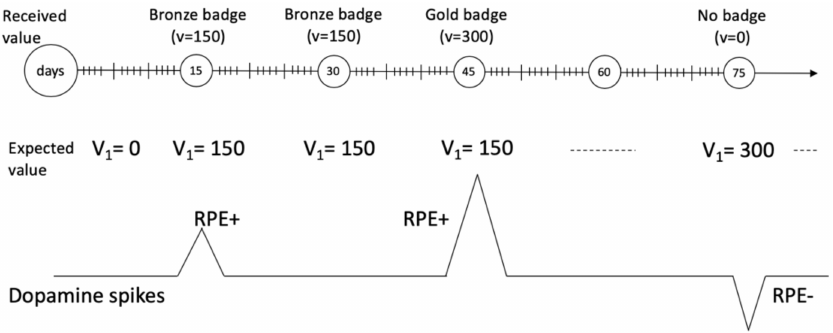
Figure 4. The timeline for incentive and the corresponding reward prediction